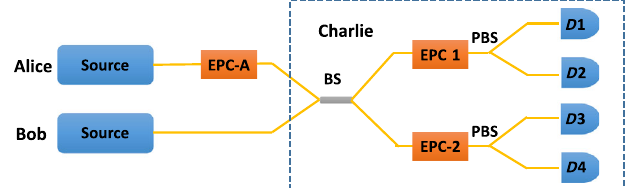
FIG. 13. Schematic of our polarization alignment system. EPC- A , EPC-1, EPC-2: electronic polarization controller; BS: beam splitter; PBS: polarization beam splitter; D 1 , D 2 , D 3 , D 4 : superconducting nanowire detector.